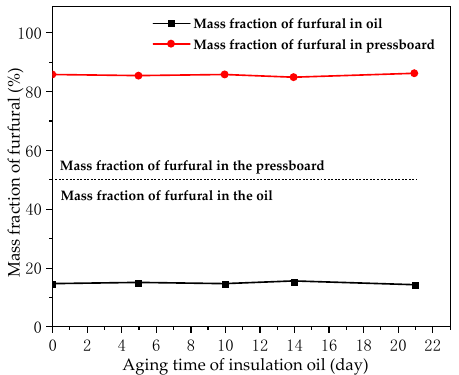
Figure 11. Mass fraction of furfural in groups composed of aged pressboard and oil with different aging degrees.